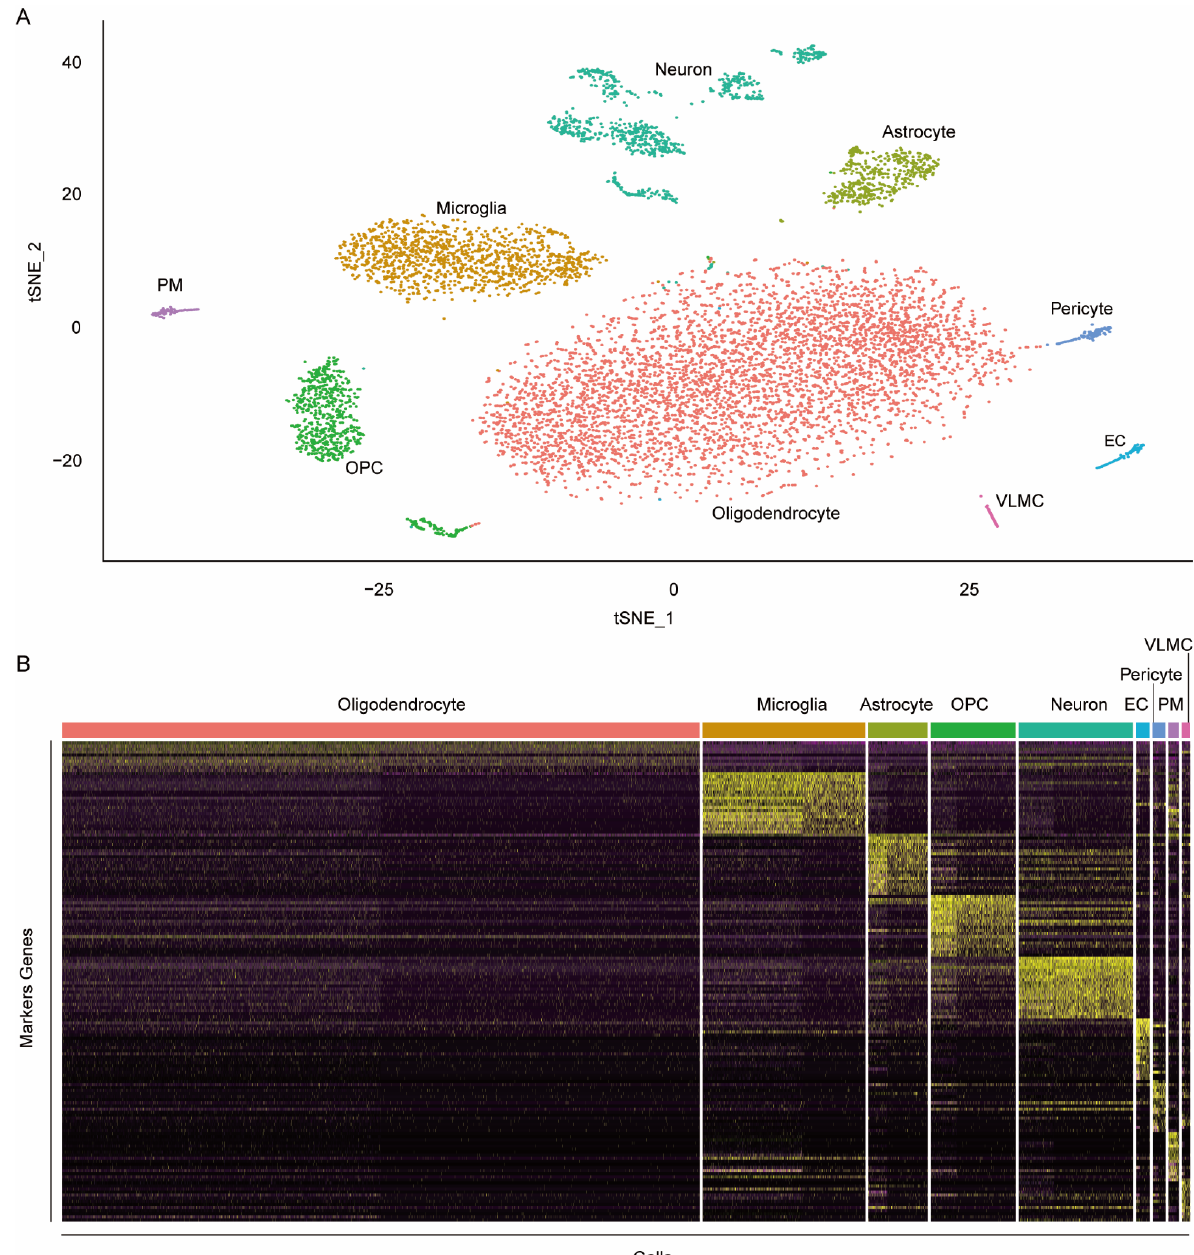
Figure 3. Single-nucleus transcriptome analysis. ( A ) The t-SNE plot of rat brain single-nucleus transcriptomes; ( B ) heatmap illustrating the expression levels of top 20 marker genes (rows) sorted by likelihood ratio for each cell type in each cell (columns), except for oligodendrocytes, which have only 10 genes.